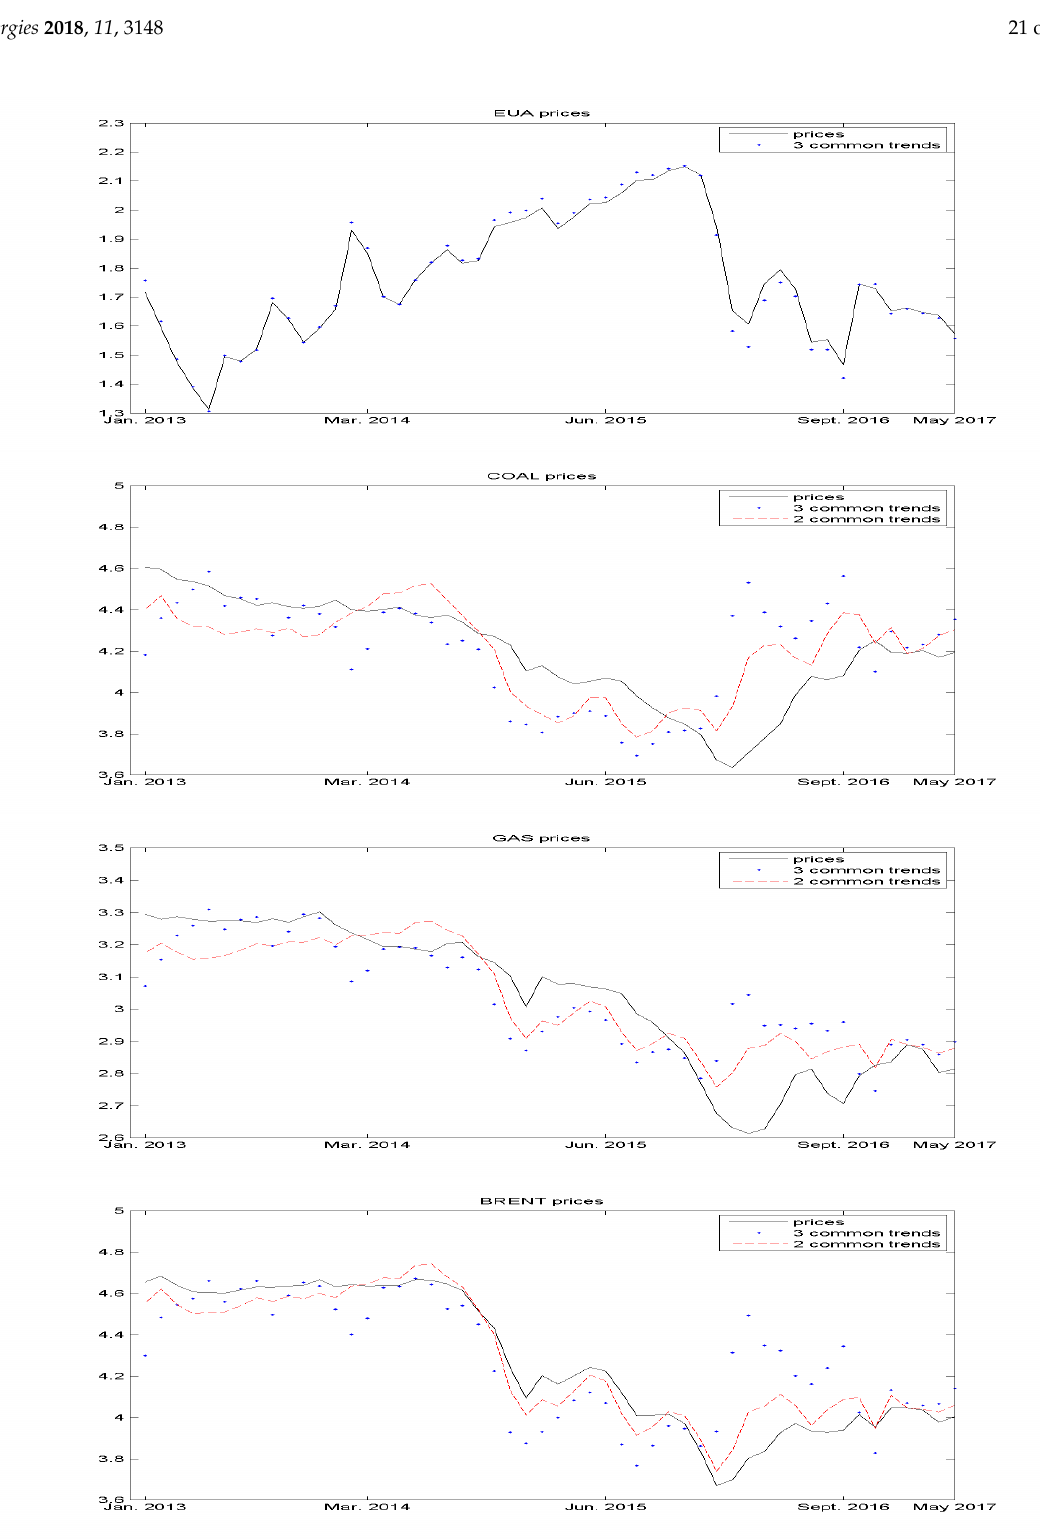
Figure 6. Permanent component A 1 f t in the decomposition (5) using the three and two common trends obtained from monthly data on Y t and (cid:101) Y t , respectively. The sample spans the period January 2013–May